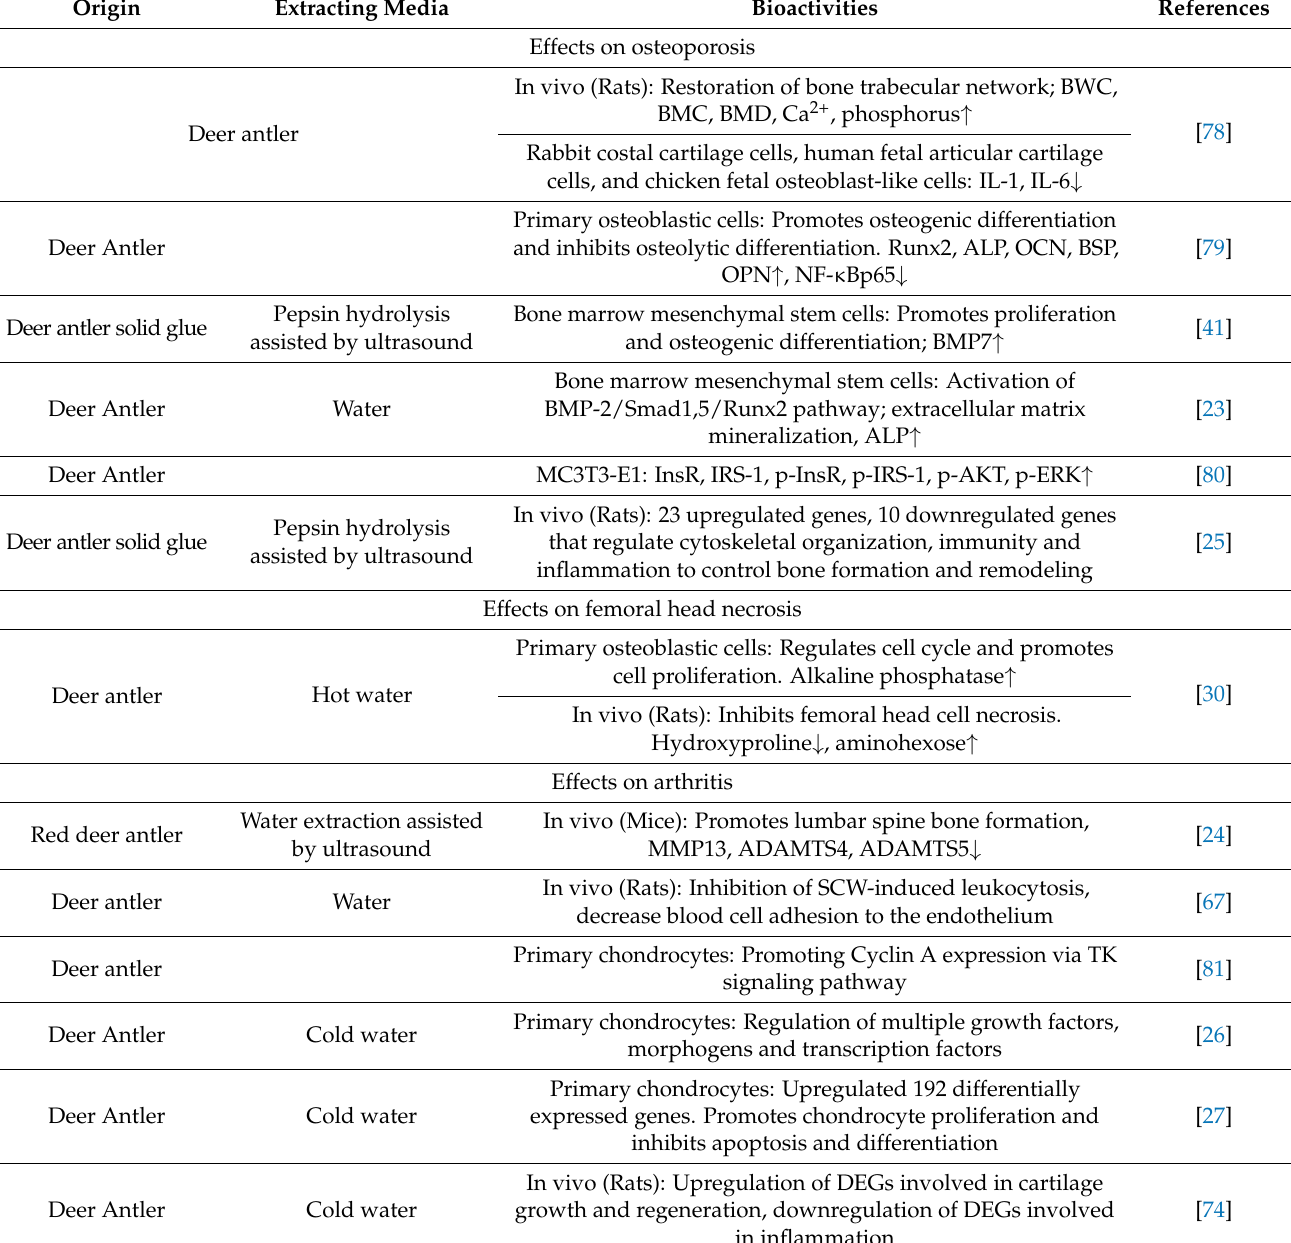
Table 5. Effect on bone and cartilage of